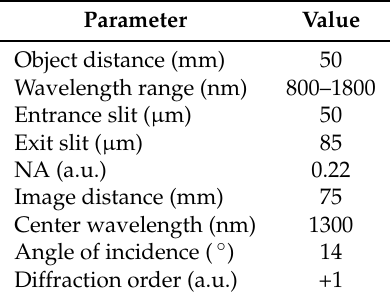
Table 2. Spectrometer